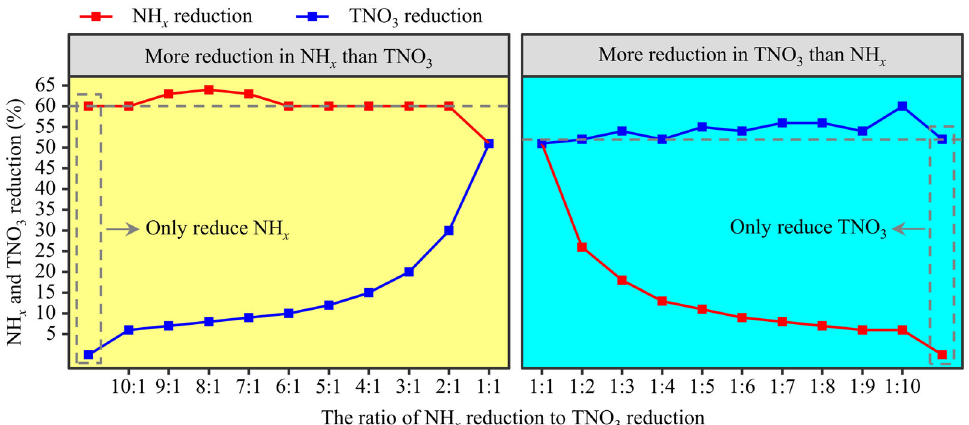
Fig. 6 Effects of simultaneous reductions of NH x and TNO 3 . The reduction threshold percentages of NH x and TNO 3 corresponding to average PM